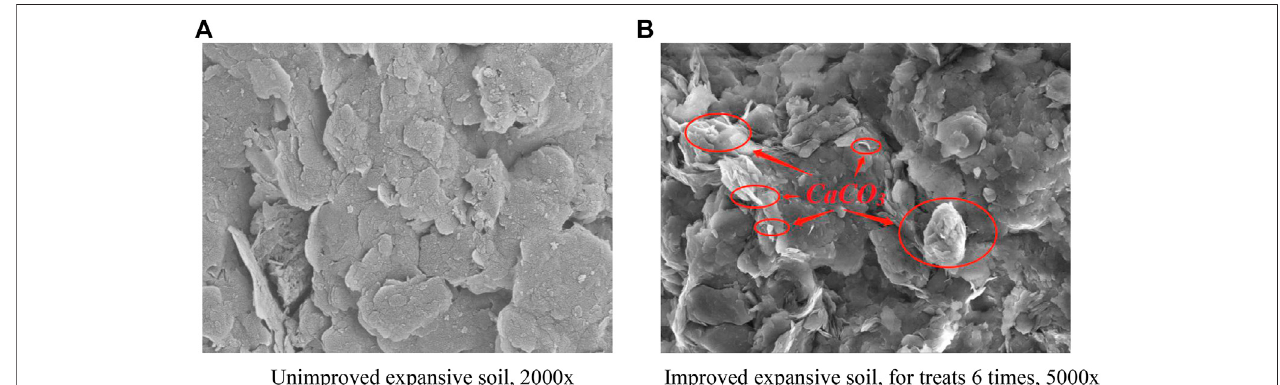
FIGURE 4 | Scanning electron microscope imaging of expansive